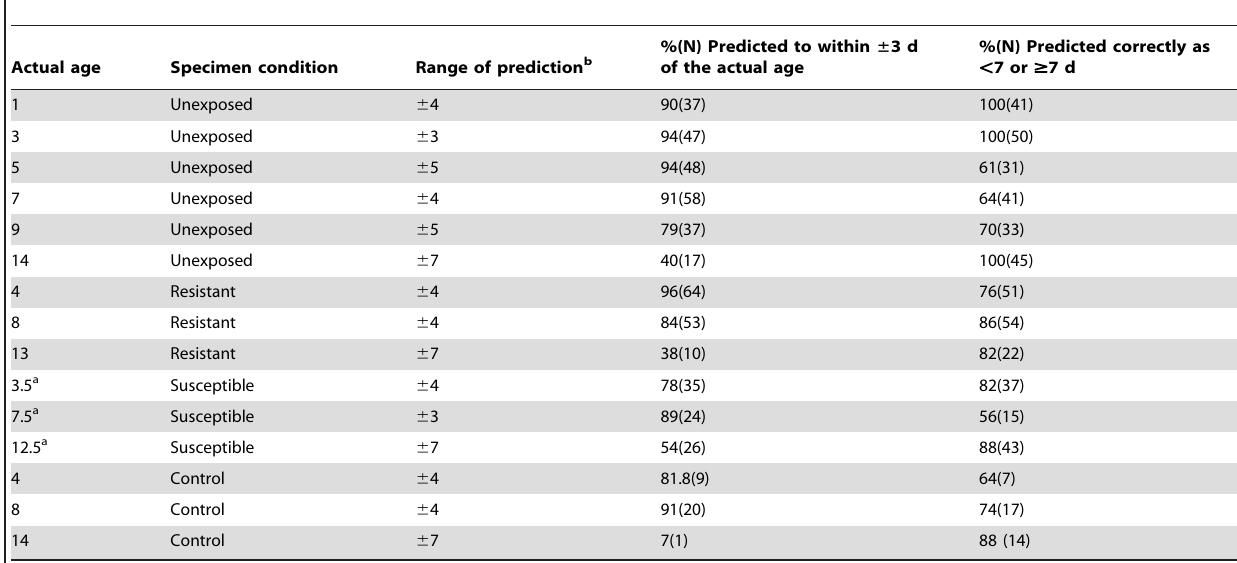
Table 2. NIRS age prediction accuracy of mixed- Anopheles spp by age and treatment at different precision levels.